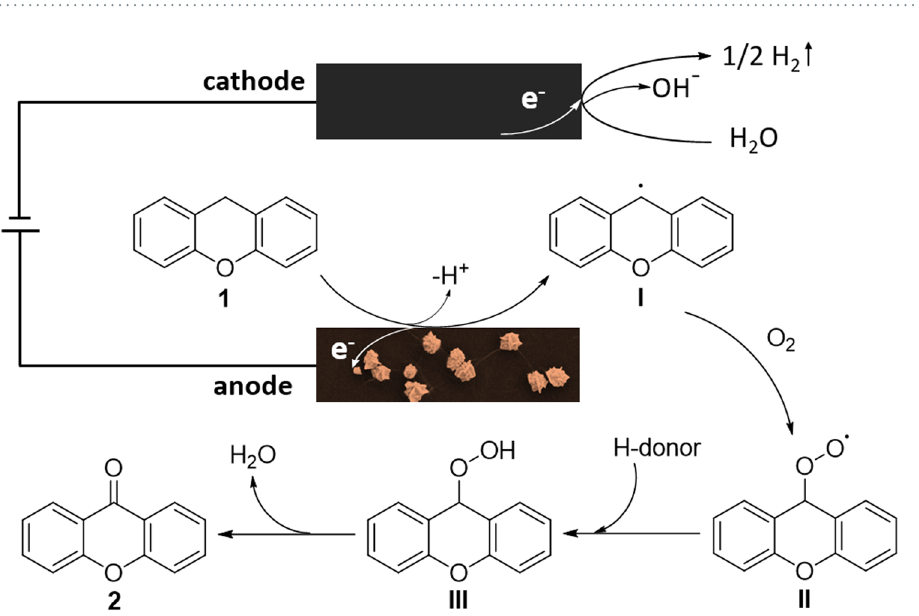
Figure 10. Proposed